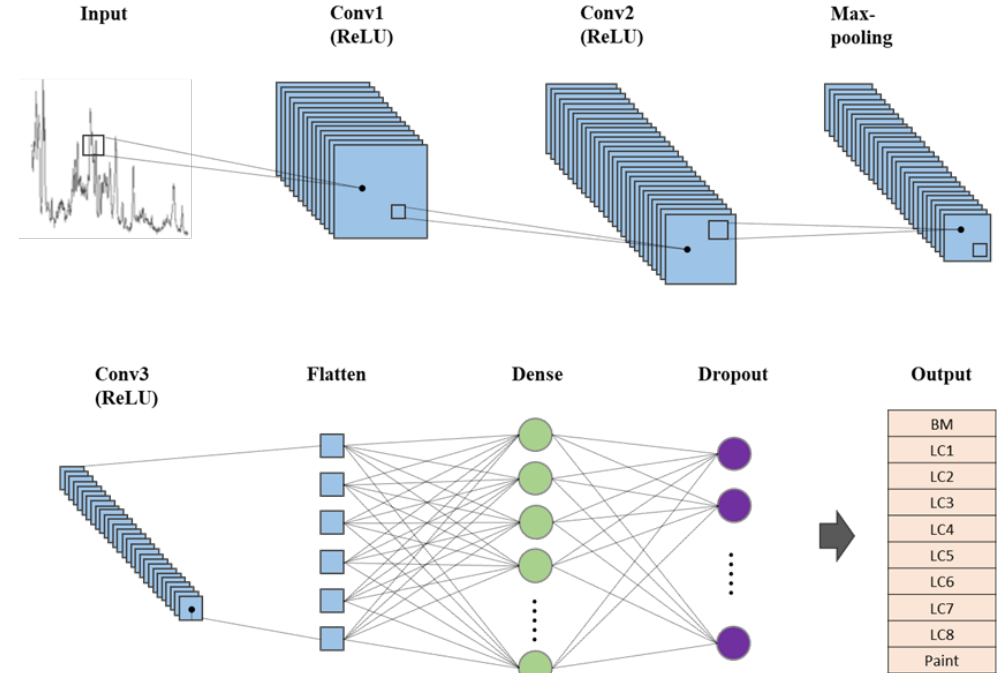
Figure 1. The structure of CNN